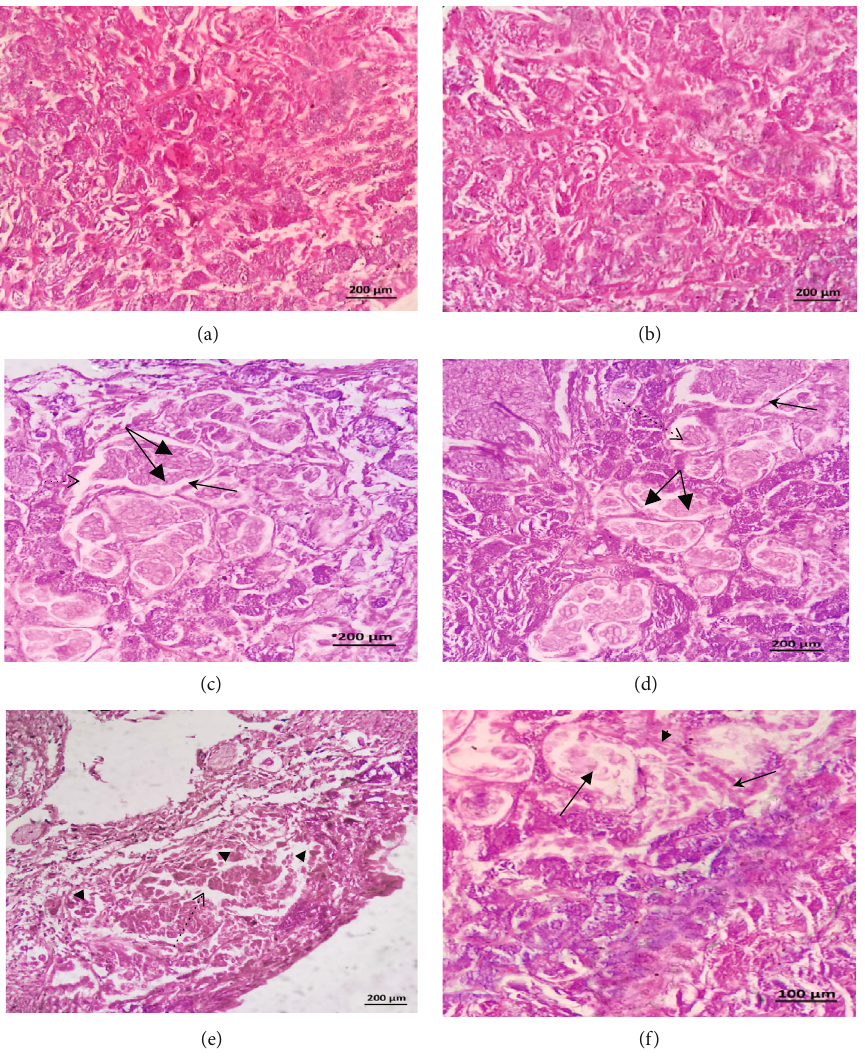
Figure 6: Histological transverse sections showed normal cephalopodal tissue structure of naïve B. truncatus snails maintained on algae or lettuce, respectively (a, b). (c, d) are of infected snails showing live mother sporocysts with normal development pattern; some of them contain single sporocyst cluster (arrowhead), and others contain multiple sporocyst clusters (twin thick arrows). All sporocysts contain viable germinal cells with nucleoli; the vacant space (dashed arrow) between the sporocyst and the tegument of the mother sporocyst also appears normal. Regarding resistant snails, cephalopodal tissue shows the sporocysts losing their characteristic cluster-like shape and dissolution of the surrounding tegument (dashed arrow), leading to dispersion of germinal cells (arrowhead) (e). The mantle collar region displays sporocycts have lost their cluster-like shape, and no viable germ cells are observed (thick arrow). Note, the negligible presence of hemocytes (thin arrow) and fi broblasts lamination (arrowhead) surrounding the sporocysts